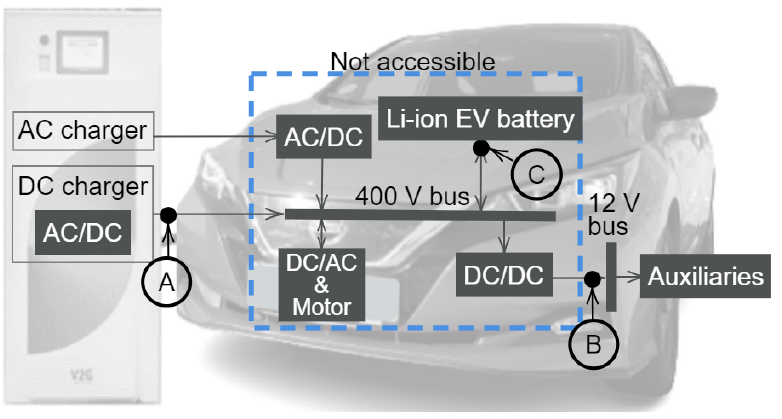
Figure 2. Overview of EV power flows. Modified from